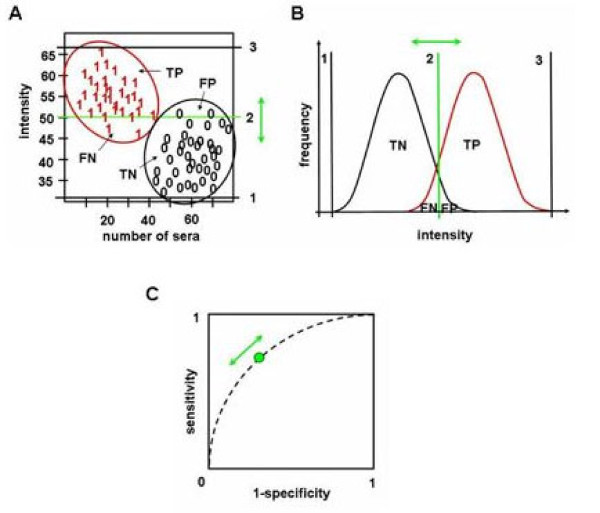
The separation of intensity values of COPD and control sera is exemplarily shown for an arbitrary antigen A. A: Intensity values of each single COPD (1) and control (0) serum for antigen A are exemplarily shown. The position of the threshold (vertical green bar (2)) determines the number of true positives (TP), true negatives (TN), false positives (FP) and false negatives (FN). The vertical bars 1 and 3 indicate the minimal and maximal thresholds. B: The two curves represent density estimations of intensity values of COPD patients (red curve) and controls (black curve) for antigen A corresponding to Figure 1A. C: The specificity (TN/(TN+FP)) and sensitivity (TP/(TP+FN)) of a test are visualized by the receiver operator characteristics (ROC) curve. The performance of the test can be represented by the area under the ROC curve (AUC). Here, the threshold is represented by the green circle. The values for sensitivity and specificity can be modified by moving the threshold.